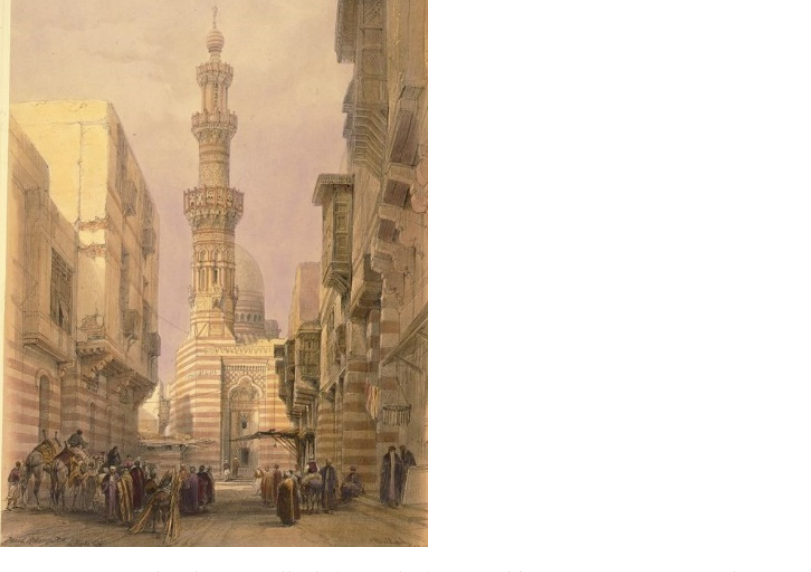
Figure 17. David Roberts, Bullack (sic Bulaq) Printed between 1846–1849. Photograph of Lithograph. Source: Library of Congress, https://www.loc.gov/item/2002718727/ (accessed on 20 April 2022).